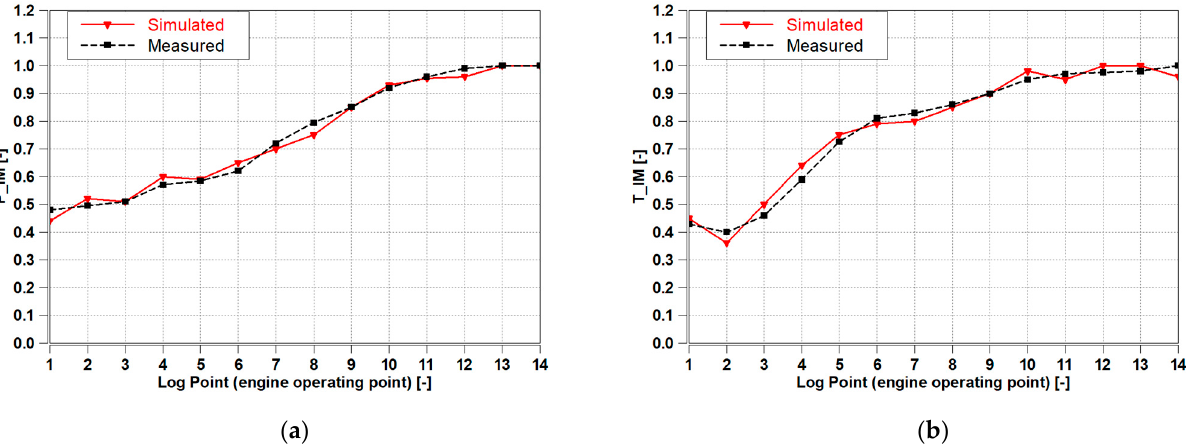
Figure 24. ( a ) Simulated (red) vs. measured (black) intake manifold pressure (normalized with respect to maximum value reached in the test); ( b ) Simulated (red) vs. measured (black) intake manifold temperature (normalized with respect to maximum value reached in the test).